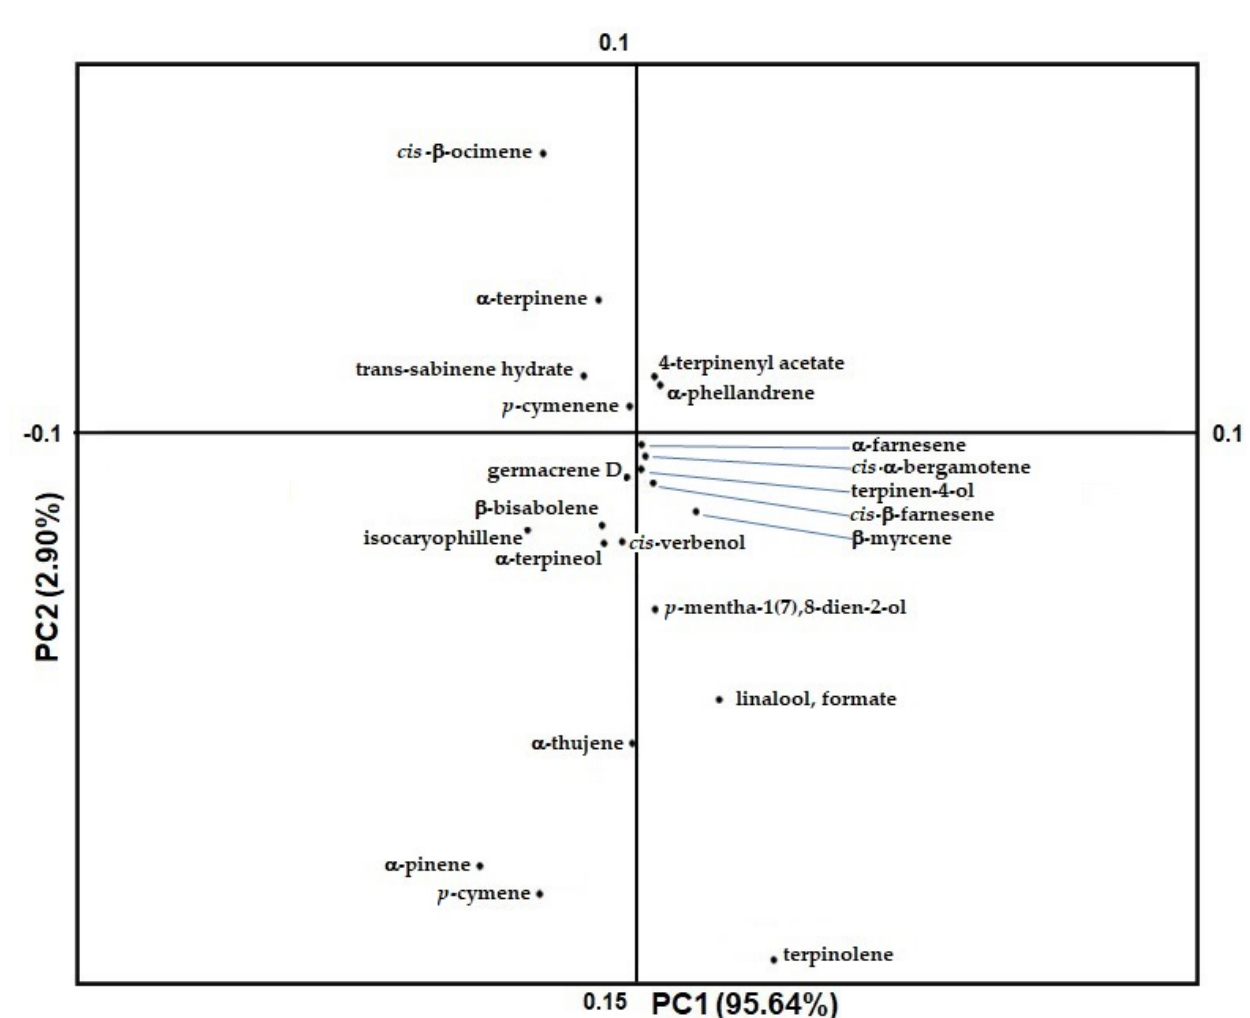
7 of 14 Figure 2. Score plot of citrus juice (outlined symbols) and peel (filled symbols) samples. Circle: Yuzu Jeune, square: Oni Yuzu, triangle: Florence cedar, diamond: Bizzarria orange. ( a ). Loading plot of volatile products extracted from citrus samples (juice and peel) ( b ). The differentiation between the four species showed the same trend considering both the volatile compounds of the juices and those of the peels. In addition, there is a clear separation between the juice samples all arranged between the first and second quadrants, and the peel samples, arranged in opposite quadrants (third and fourth) (Figure 2a). In this regard, the differentiation between juice and peel is much wider in the Florence cedar and to a slightly lesser extent in the Bizzarria orange than in the other two species. The loading plot (Figure 2b) is dominated by limonene in the second quadrant of the graph, and by γ -terpinene in the first quadrant of the graph. They are by far the first and second most abundant compounds, respectively, and are responsible for separation of